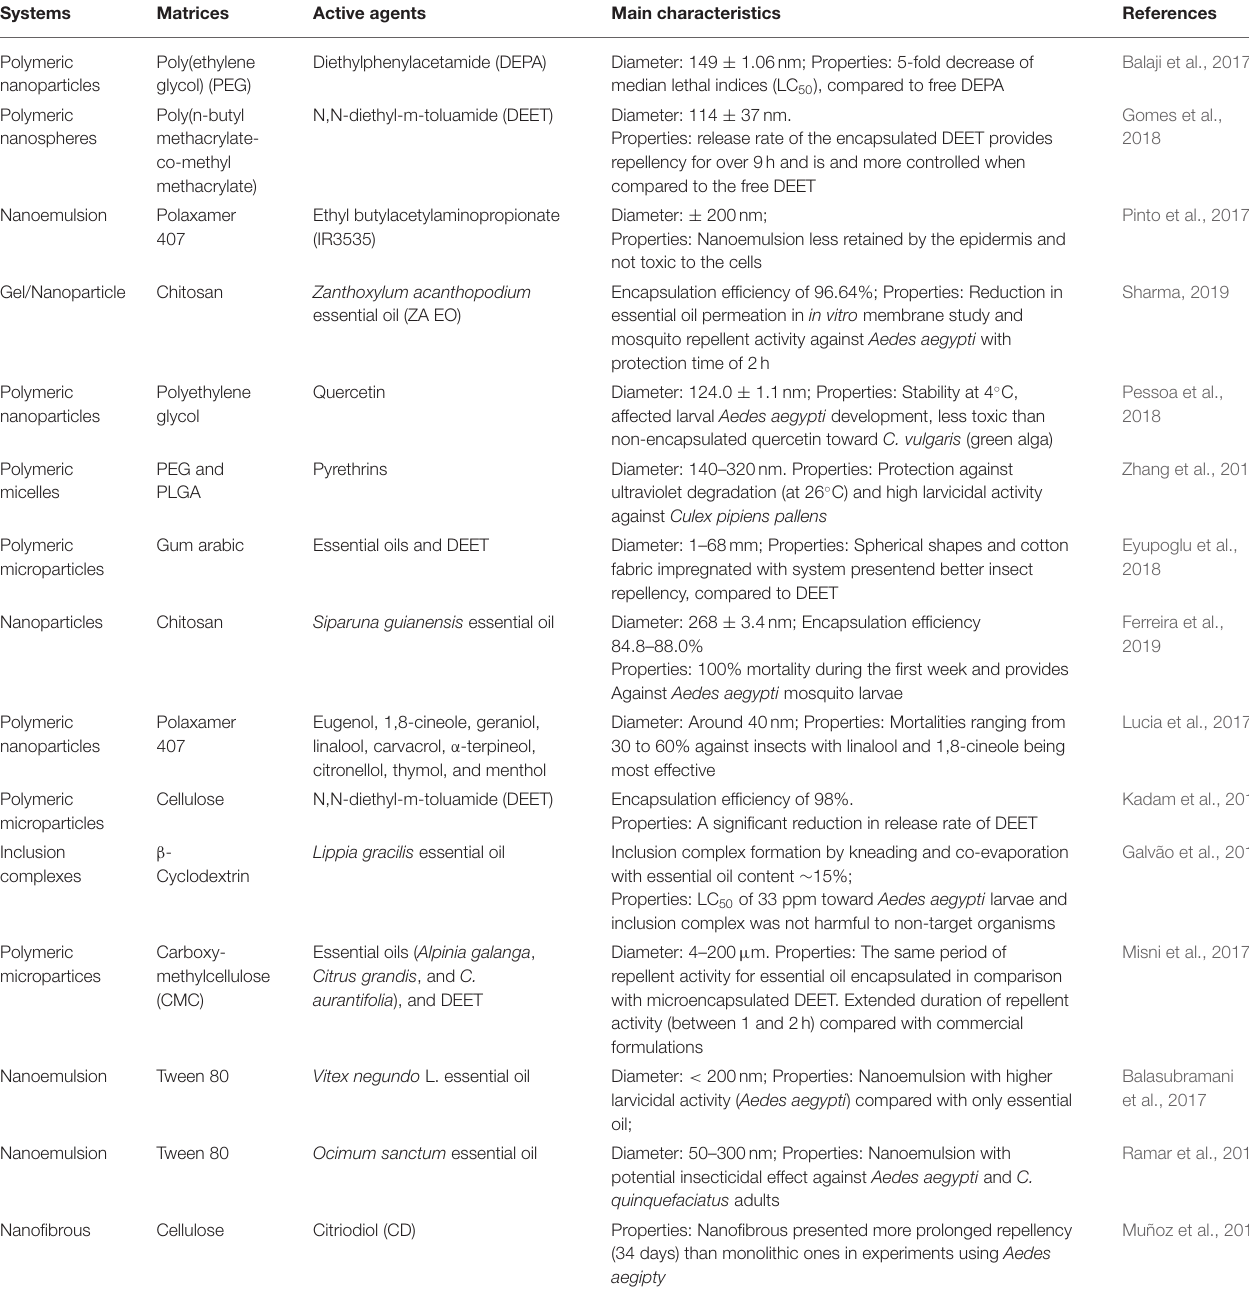
TABLE 3 | Formulations based on modified release systems for the encapsulation of active agents with insect repellent